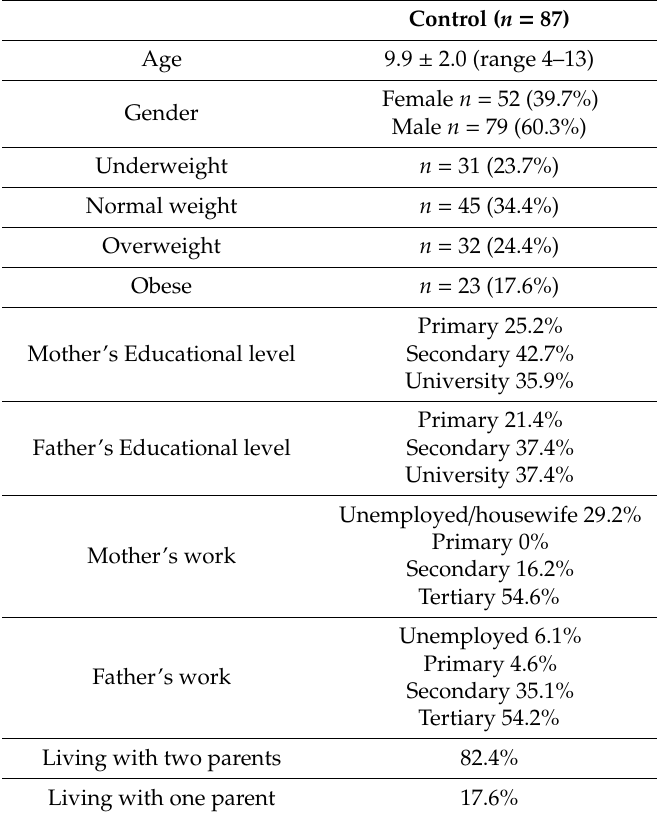
Table 1. Characteristics of the study